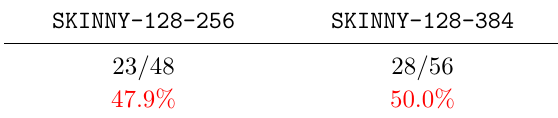
Table 8: Number of rounds of SKINNY that can be attacked by the best key-recovery attacks (in the related-tweakey model) known so